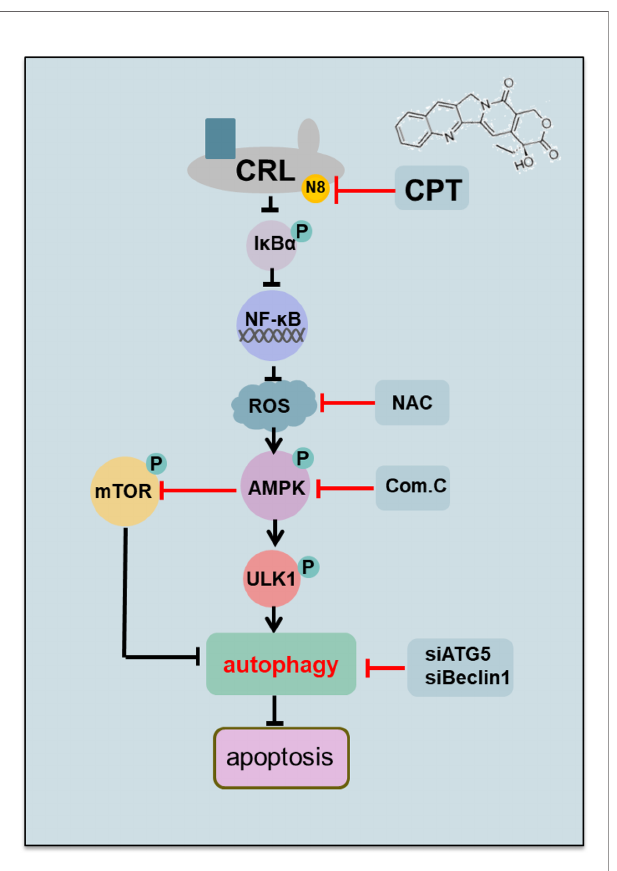
FIGURE 6 | Working model. CPT inhibited cullin neddylation, inactivated CRLs and induced the accumulation of classical CRL substrates p-I k B a . Mechanistic investigations further revealed that the neddylation inhibition by CPT induced the generation of ROS to modulate AMPK/mTOR/ULK1 axis to induce autophagy in esophageal cancer